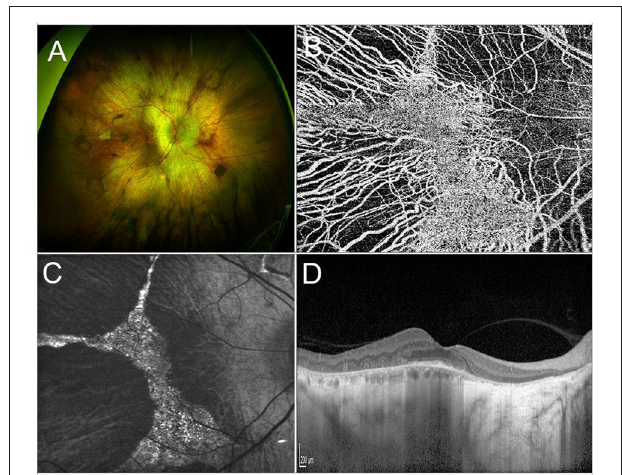
FIGURE 3 | Multimodal imaging in CHM. (A) Ultra-wide field retinography shows a widespread chorioretinal atrophy, with a central islet of retinal sparing. (B) OCTA detects the sparing of the choriocapillaris vascular layer limited to the central islet. (C) Fundus autofluorescence displaying a central hyperautofluorescent region surrounded by hyporeflective atrophic tissue. (D) Structural OCT scan passing shows chorioretinal atrophy and outer retinal tubulations in the parafovea and a relative sparing of the photoreceptor layer in the